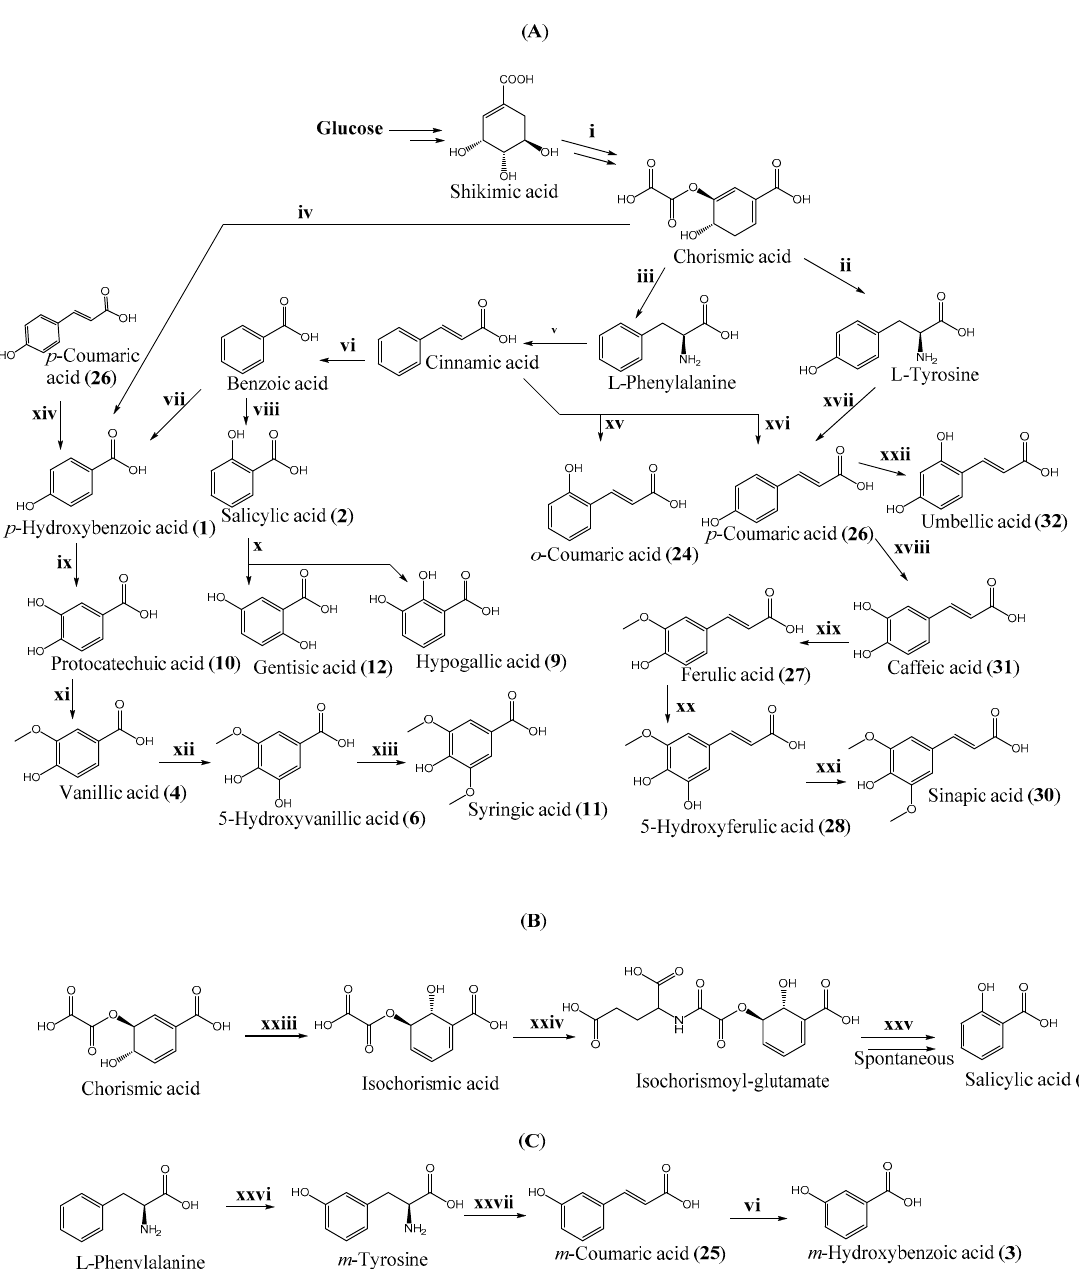
Figure 1. General scheme for the phenolic acid biosynthesis through the shikimate pathway ( A ), salicylic acid biosynthesis from isochorismate ( B ), and m -coumaric acid biosynthesis ( C ). Enzymes involved in the reactions: (i) shikimate kinase, 5-enolpyruvylshikimate-3-phosphate synthase and chorismate synthase; (ii) chorismate mutase, prephenate dehydrogenase; (iii) chorismate mutase, prephenate aminotransferase, arogenate dehydratase; (iv) chorismate-pyruvate lyase; (v) L-phenylalanine ammonia lyase (PAL); (vi) oxidase (or presumed β -oxidation); (vii) benzoic acid 4-hydroxylase; (viii) benzoic acid 2-hydroxylase; (ix) 4-hydroxybenzoic acid 3-hydroxylase; (x) salicylic acid 3-hydroxylase (S3H); (xi) protocatechuic acid 3-O-methyltransferase; (xii) vanillic acid 5-hydroxylase; (xiii) vanillic acid 5-O-methyltransferase; (xiv) 4-hydroxybenzaldehyde synthase and 4-hydroxybenzaldehyde dehydrogenase; (xv) cinnamic acid 2-hydroxylase; (xvi) cinnamic acid 4-hydroxylase; (xvii) tyrosine ammonia lyase (TAL); (xviii) p -coumaric acid 3-hydroxylase; (xix) ca ff eic acid 3-O-methyltransferase; (xx) ferulic acid 5-hydroxylase; (xxi) ca ff eic / 5-hydroxyferulic acid O-methyltransferase (COMT); (xxii) p -coumaric acid 2-hydroxylase; (xxiii) isochorismate synthase (ICS); (xxiv) isochorismoyl-glutamate synthase (IGS); (xxv) isochorismoyl-glutamate A pyruvoyl-glutamate lyase (IPGL); (xxvi) cytochrome P450; (xxvii)